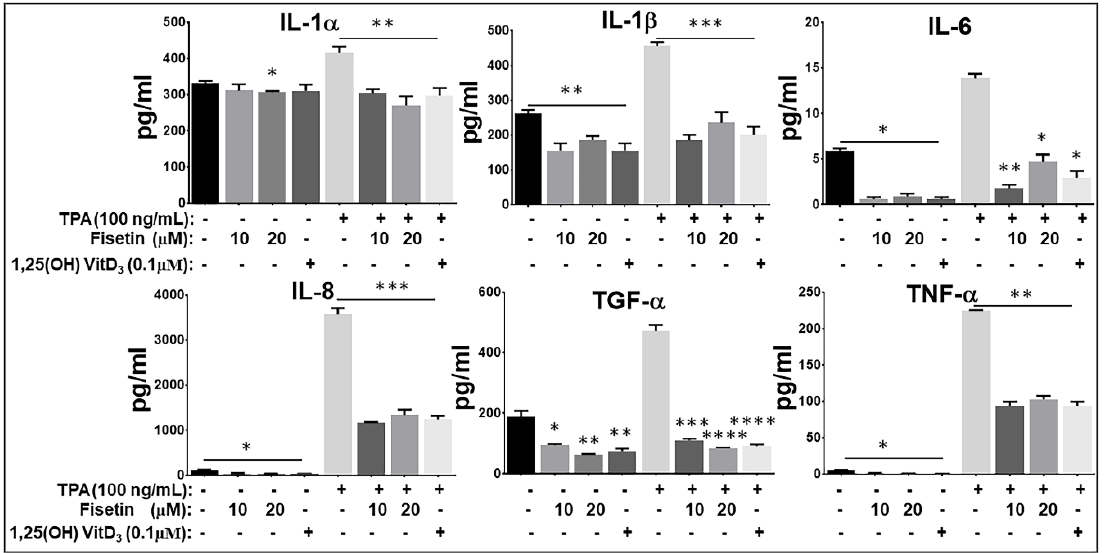
Figure 5. Fisetin reduces the inflammatory response in 12-O-tetradecanoyl-phorbol-13- acetate (TPA)-activated NHEK. NHEKs were pretreated with or without di ff erent concentrations of fisetin (10 and 20 µ M) for 24 h, before stimulation with or without 100 ng / mL of TPA. The release of pro-inflammatory cytokines (IL-1 α , IL-1 β , IL-6, IL-8 (CXCL8), TNF- α , and TGF- α ) in condition culture media was measured by Procarta-based multiplex immunoassay. Fisetin pretreatment suppressed TPA-induced secretion of these proinflammatory mediators to values similar to that of 1, 25 dihydroxyvitamin D3 (Vitamin D3) pretreatment. Values are the mean ± SD of results from three independent experiments each performed in quadruplicate. Statistical significance was determined using one-way ANOVA and Tukey’s multiple comparison test. Significance of comparisons were made for TPA-stimulated alone cells versus TPA-stimulated and fisetin / vitamin D 3 -treated cells, and also between unstimulated control cells versus fisetin / vitamin D3-treated cells, as denoted by * p < 0.05, ** p < 0.01, *** p < 0.001, and **** p < 0.0001.